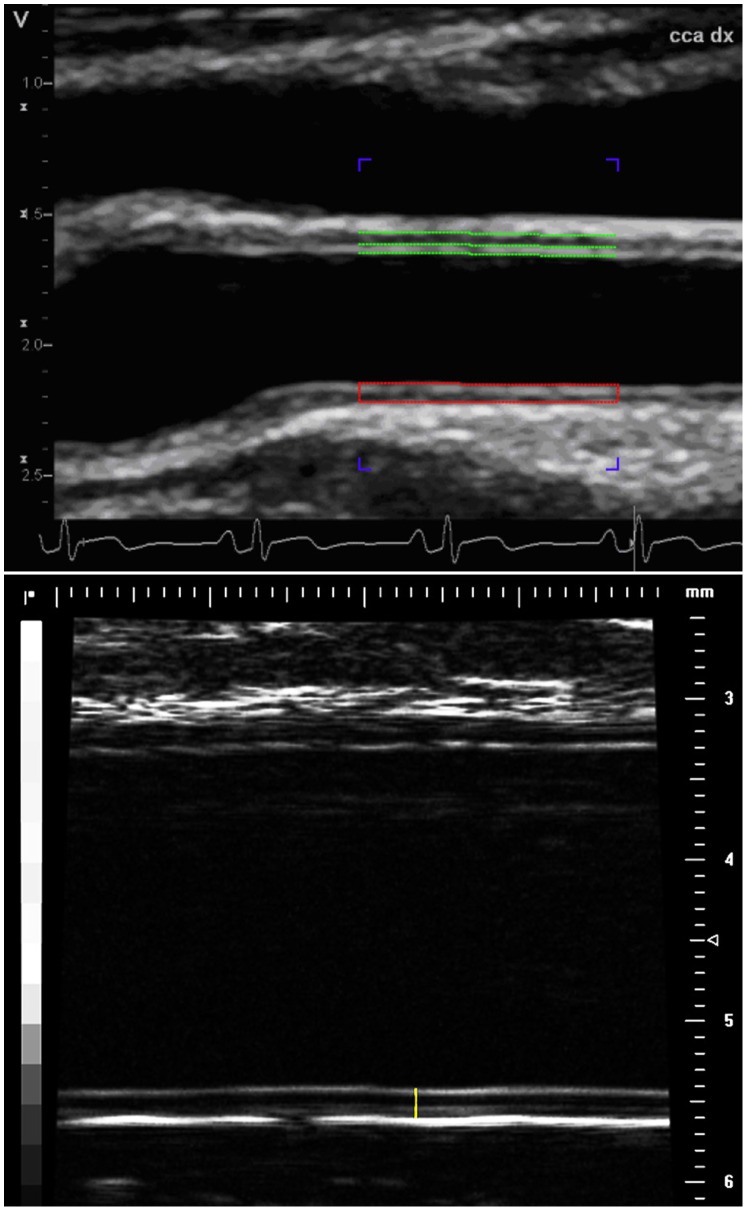
Carotid and radial artery ultrasound images.The red rectangular outline in the upper panel delineates the measurement of the right common carotid artery far wall intima media thickness (IMTcca) and grayscale median (IM-GSM). The vertical yellow line in the lower panel indicates the intima media thickness of the radial artery (IMTrad).